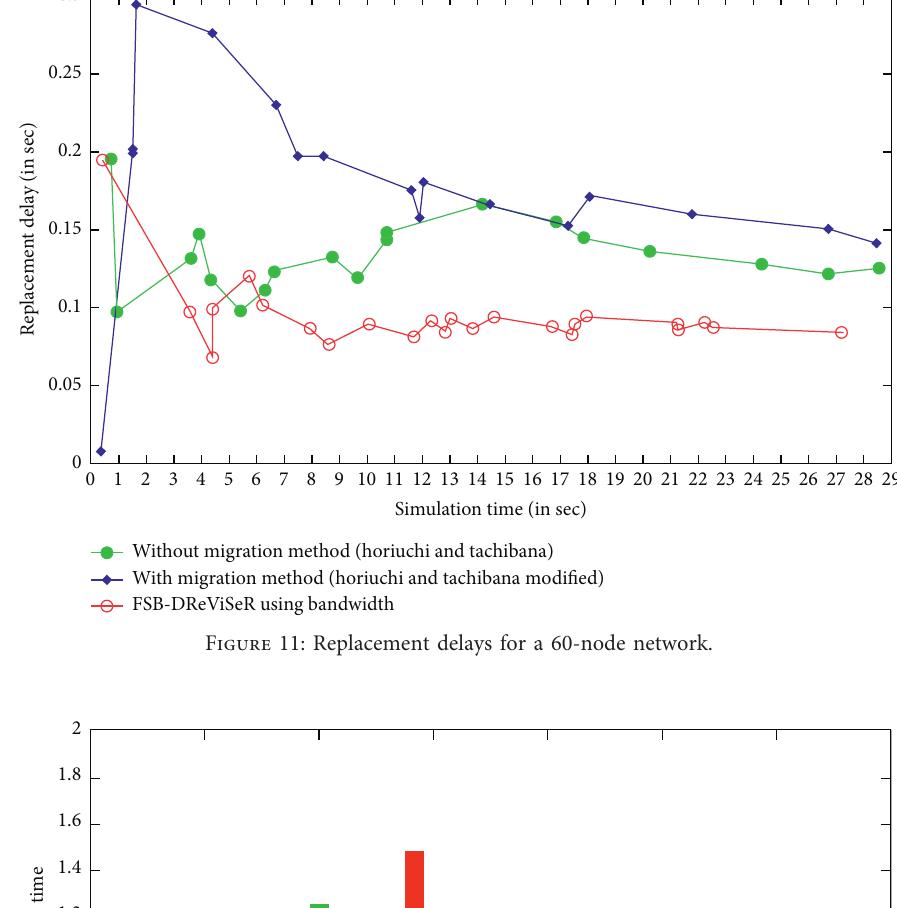
Figure 11: Replacement delays for a 60-node network.